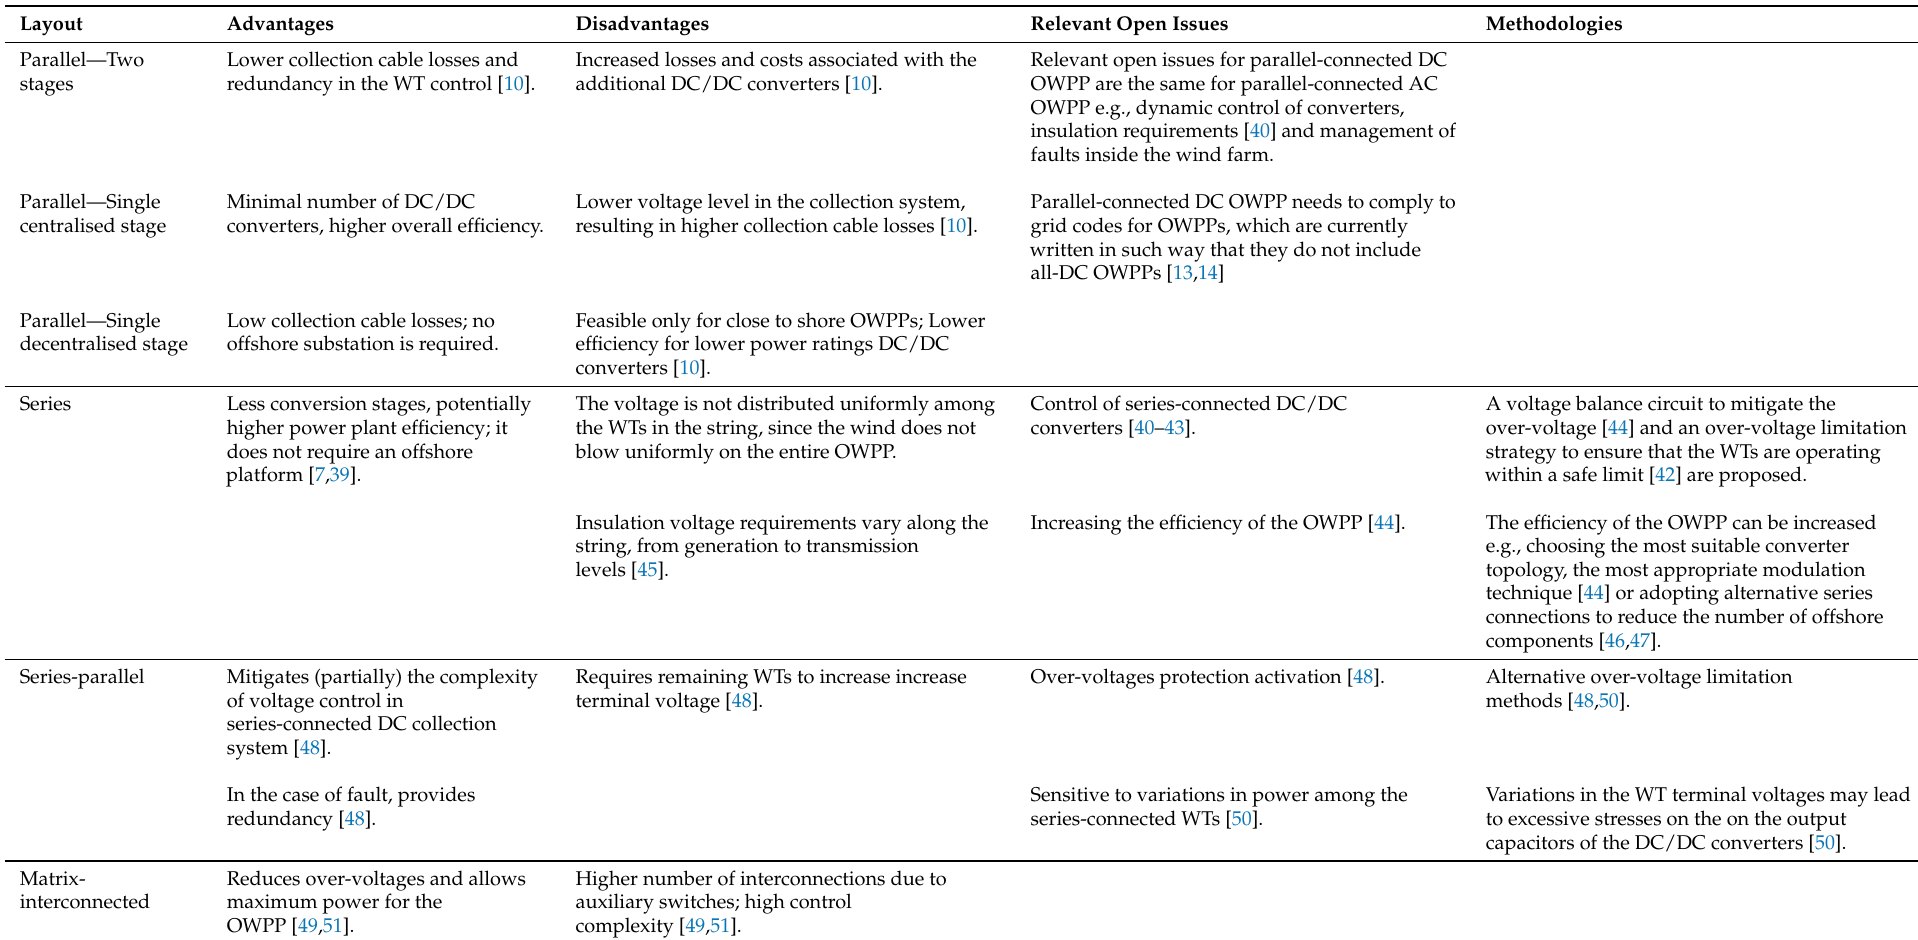
Table 2. Summary of DC collection system